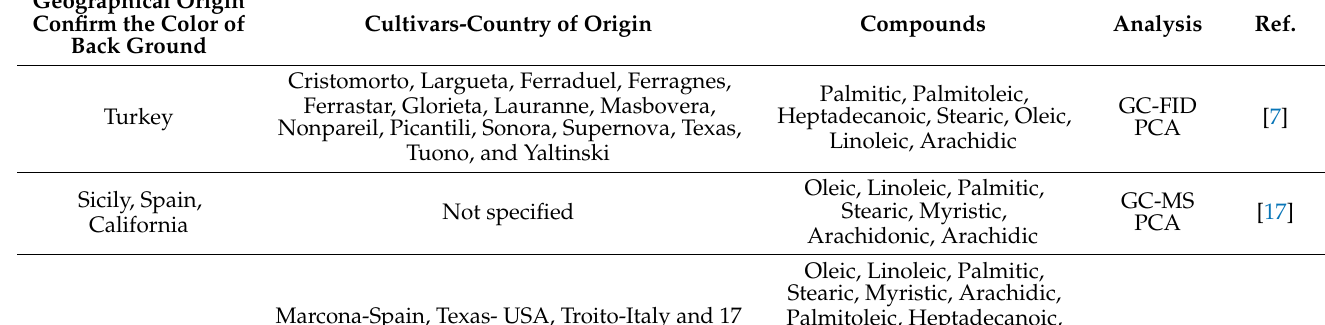
Table 2. Characterization of almonds of different geographical origins and cultivars based on their fatty acid composition. Geographical Origin Confirm the Color of Back